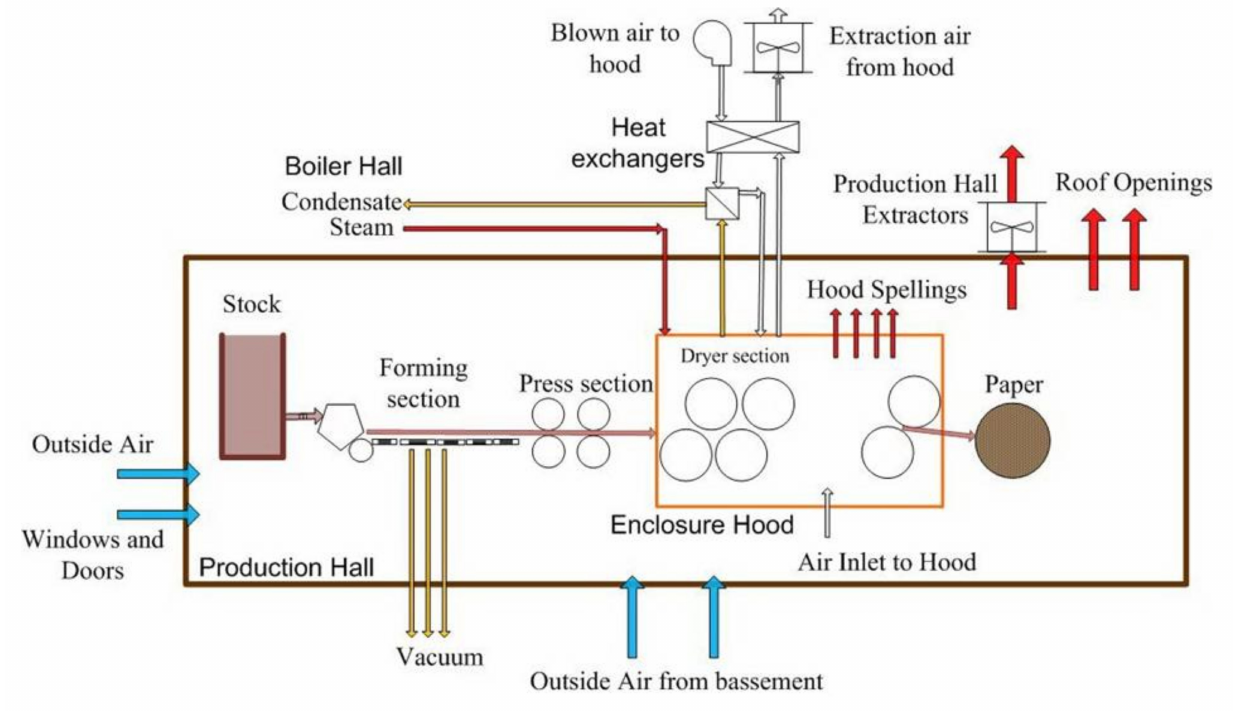
Figure 1. Process